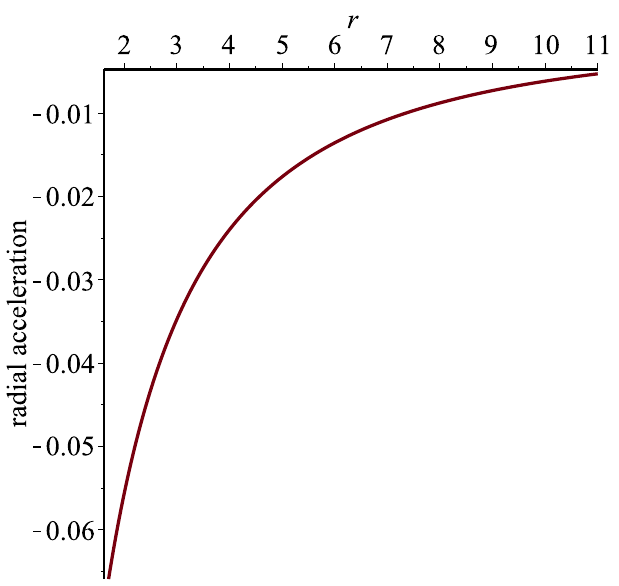
Figure 10. Behaviour of ¨ r for the Schwarzschild geometry in Kerr–Schild coordinates for m = 1 and (cid:101) = 1. Note the coordinate acceleration remains negative between the horizon and spatial